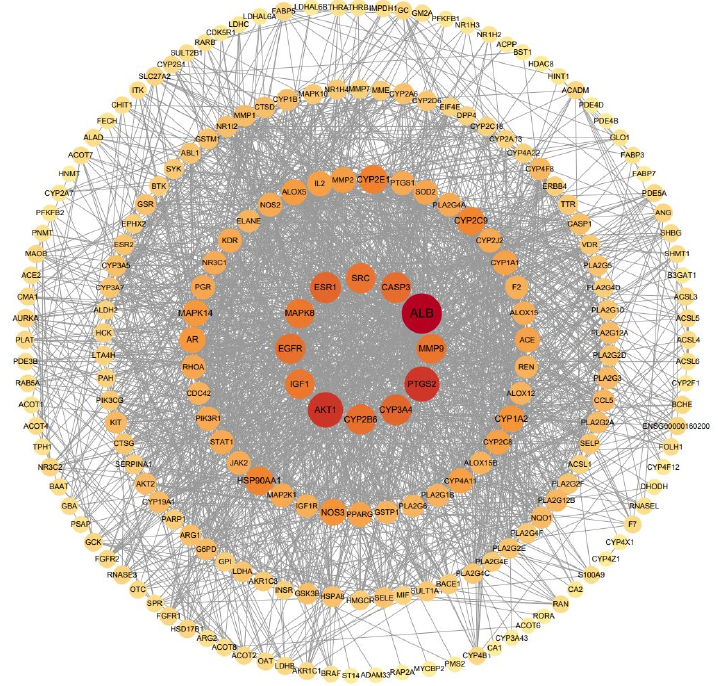
Figure 8. PPI network of the metabolomics and network pharmacology comprehensive targets.